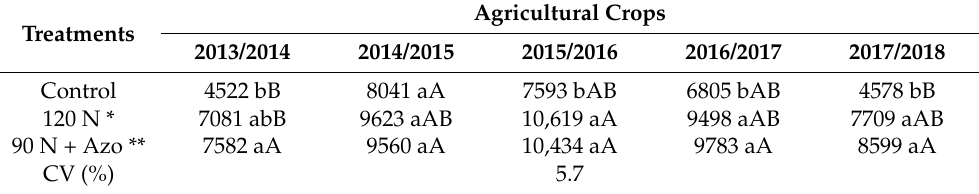
Table 6. Production of dry matter of rice plants (kg ha − 1 ) as a function of treatments with and without nitrogen and combined with Azospirillum brasilense . Means of four applications. Crops 2013/14–2017/18.